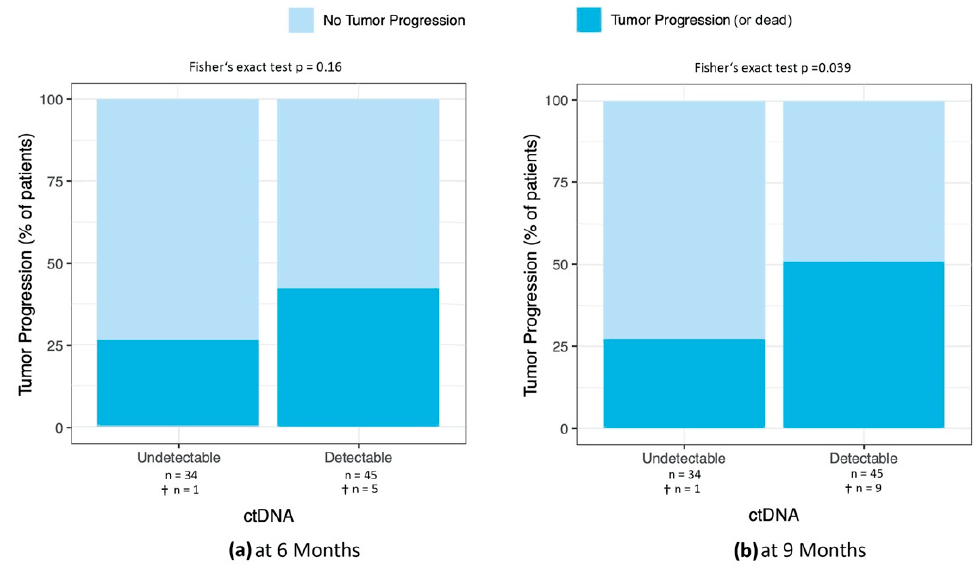
Figure A1. ( a ) Percentage of patients with tumor progression at 6 months after ctDNA sample collection in patients with detectable and undetectable ctDNA. ( b ) Percentage of patients with tumor progression at 9 months in patients with detectable and undetectable ctDNA. The p -value was determined using Fisher’s exact test. †: Number of patients who died.